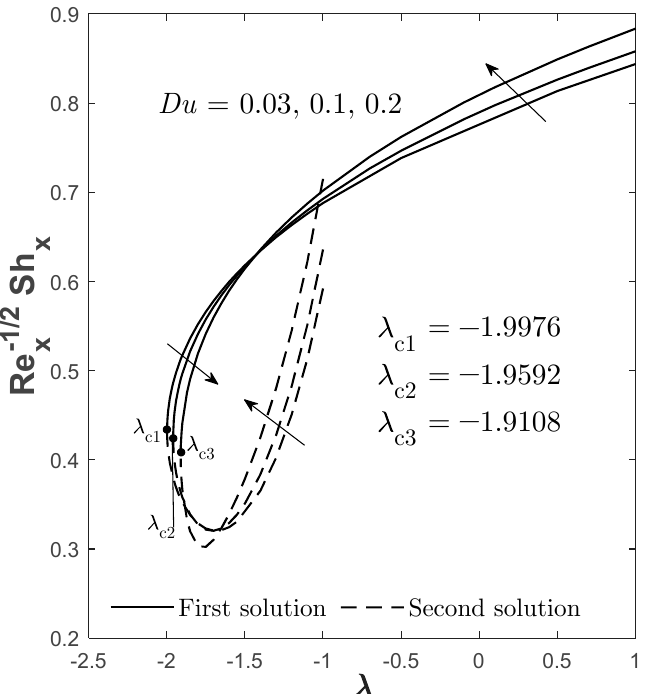
Figure 7. Re − 1/2 x Sh x for varied Du when N = Rd = Sc = Sr = 1, φ 2 = 0.01, and Bi = Sh − for varied Du when Figure 7. 1/2 Re x x Sh − for varied Du when 1 N Figure 7. 1/2 Re x x